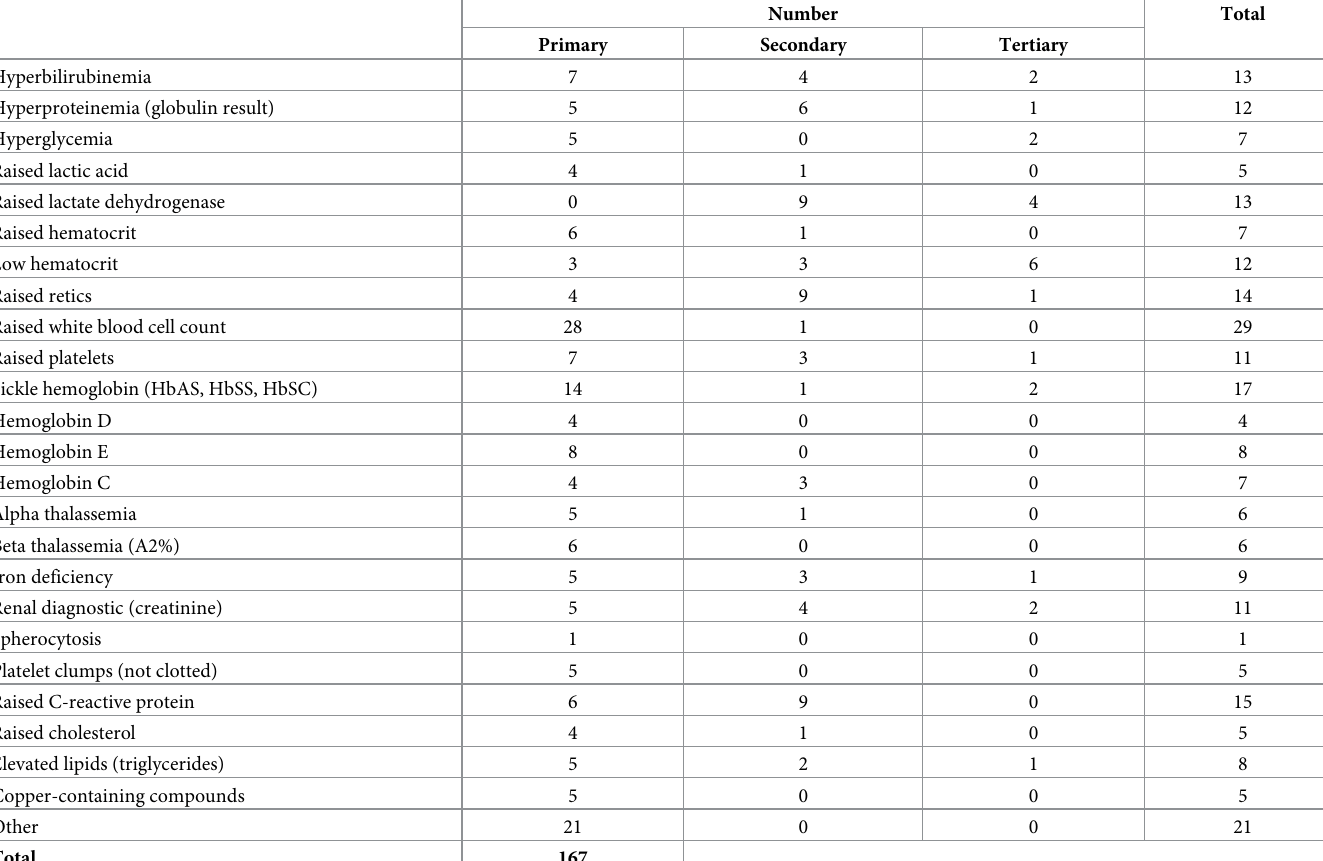
Table 3. Inventory of blood specimens and laboratory-confirmed blood disorders and potential endogenous interfering substances for the 167 specimens tested in the study performed at Hammersmith Hospital, United Kingdom. Multiple disorders were associated with some specimens and were counted as secondary and tertiary samples in the